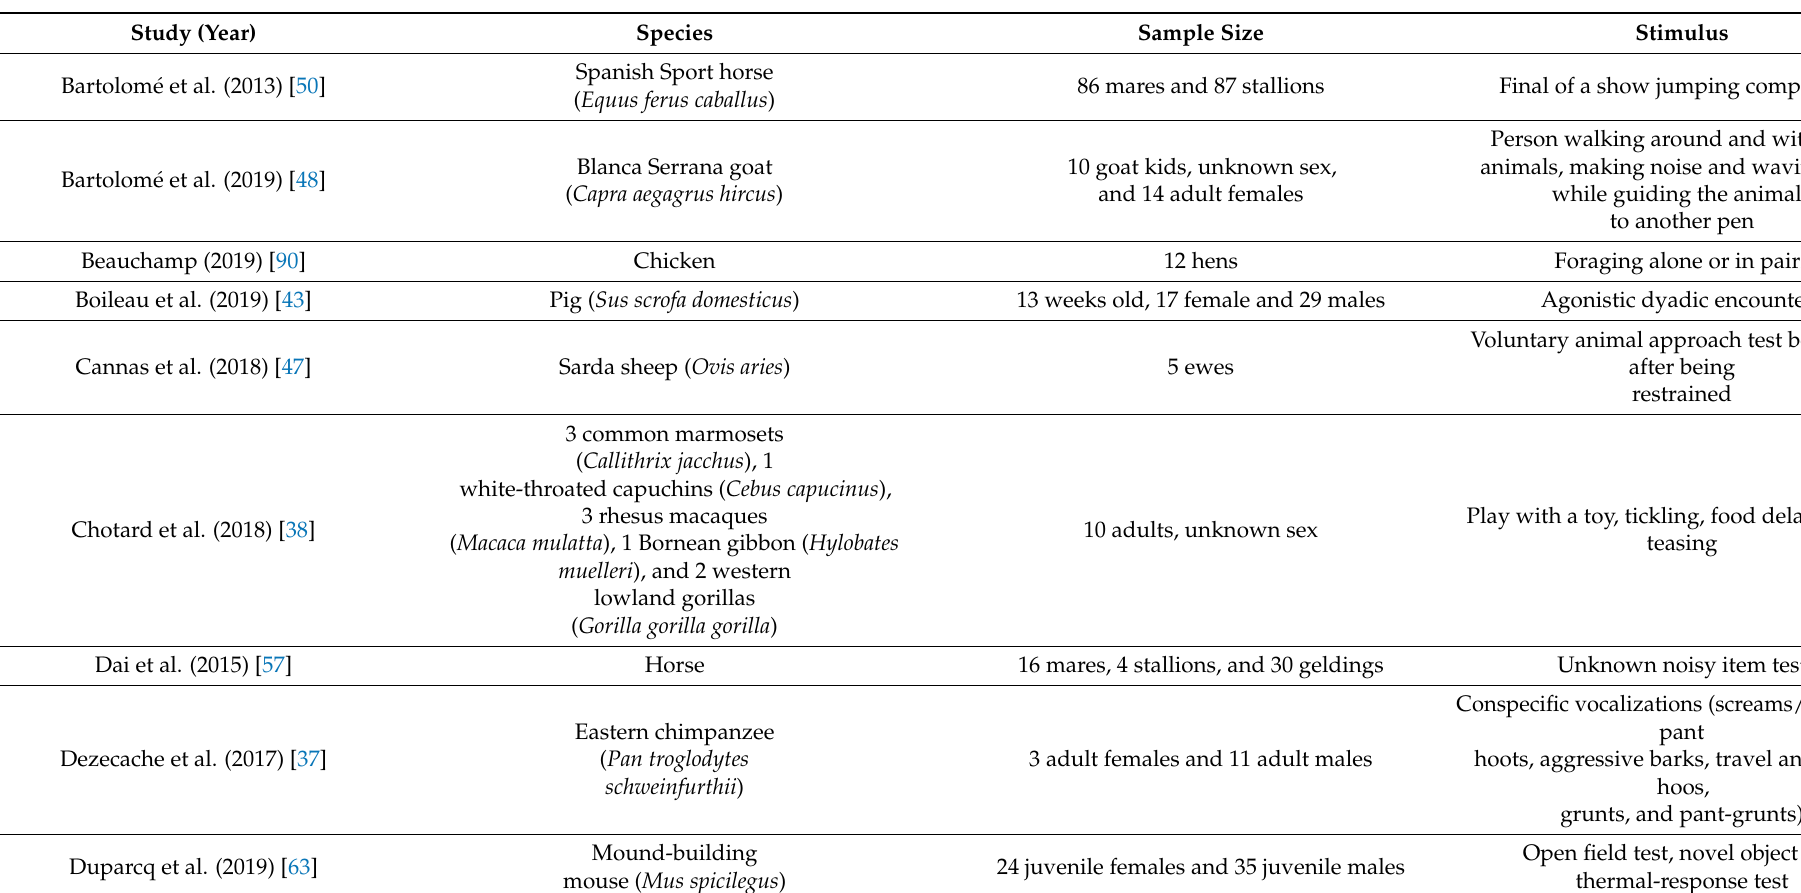
Table A1. Characteristics of the sample and the